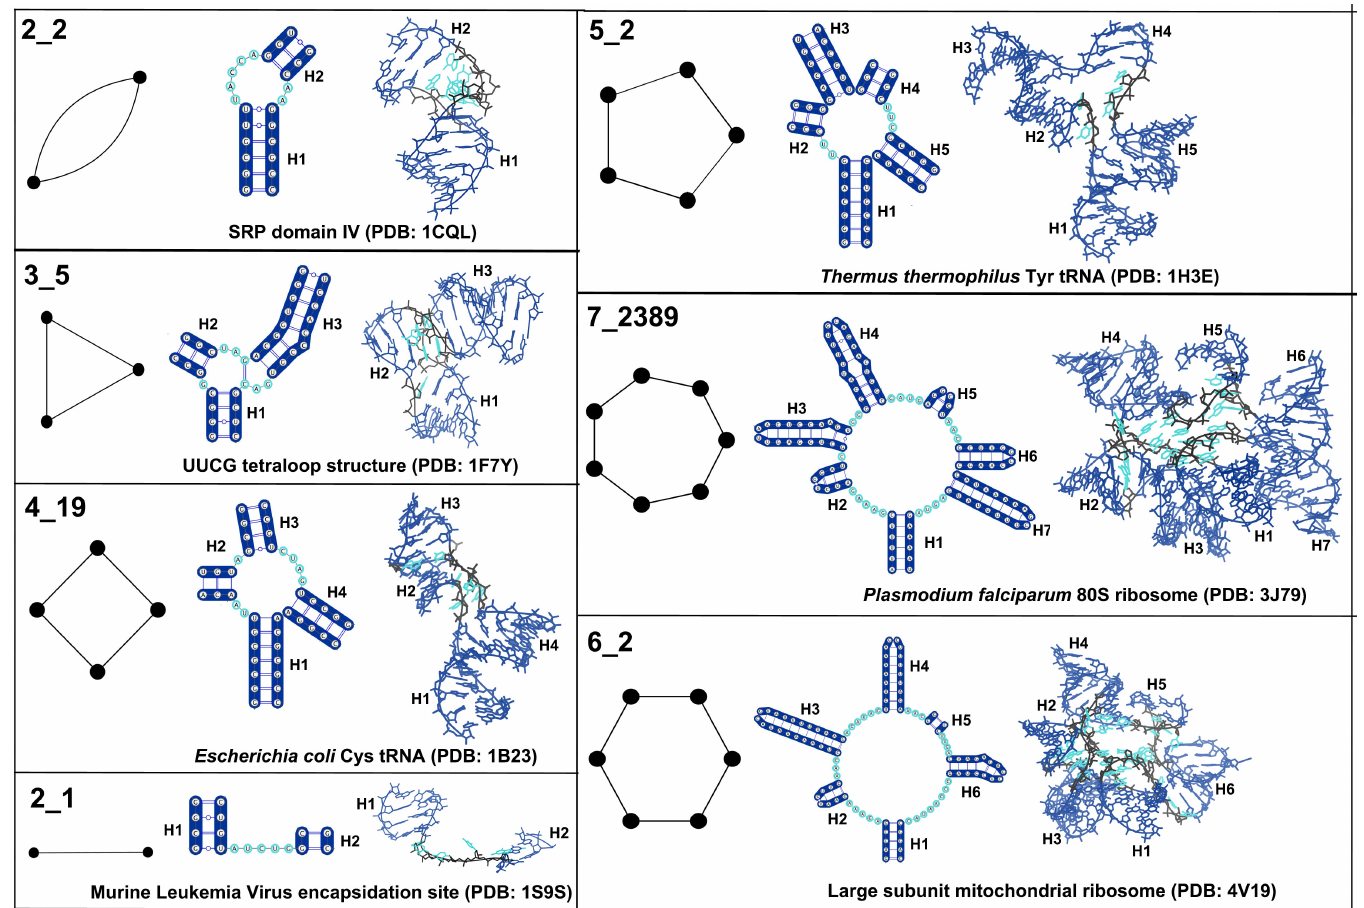
Figure 5. Common subgraph blocks without pseudoknots. Shown for each dual graph block topology with 10 or more occurrences (found by partitioning dual graphs in the representative RNA dataset) are the 2D and 3D structure fragments of one representative example. The same colors in the 2D and 3D structures correspond to similar regions. Helices are marked as Hi , where i indicates the helix